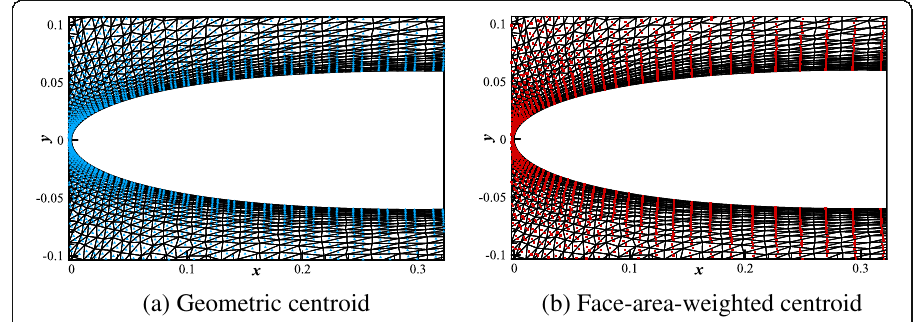
Fig. 25 ( a ) Geometric centroid and ( b ) face-area-weighted centroid of perturbed triangular grid over a